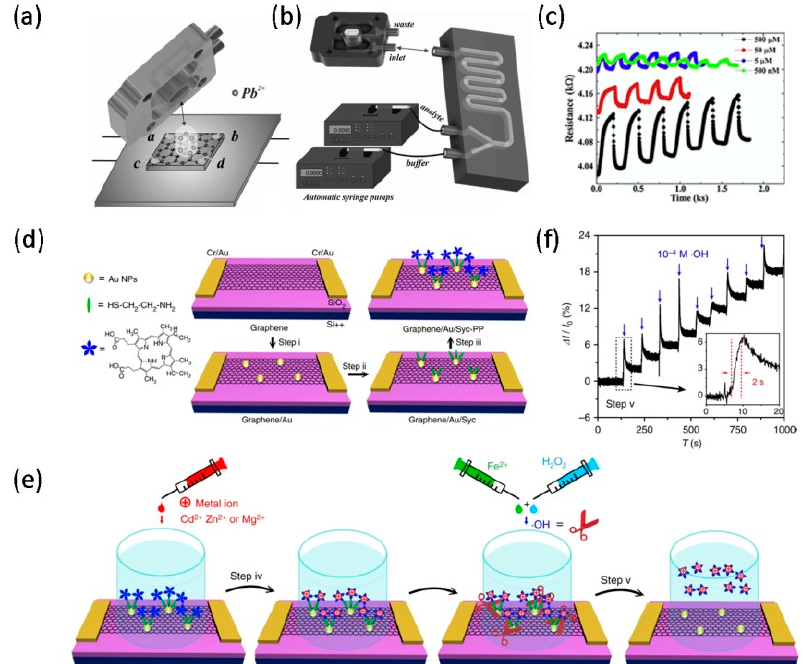
Figure 5. Diagram of the internal structure of the microfluidic chip ( a ) and the entire experimental equipment ( b ). ( c ) Sensor signals corresponding to different Pb 2+ concentrations as a function of time. Reproduced from [41] with the permission from Elsevier. ( d ) Schematic diagram of the manufacturing process of a field-effect transistor (FET) sensor. ( e ) Schematic diagram of FET sensor • OH detection. ( f ) the real-time response signal of the microfluidic FET sensor after adding • OH. Reproduced from [96] with the permission from Nature Publishing Group.